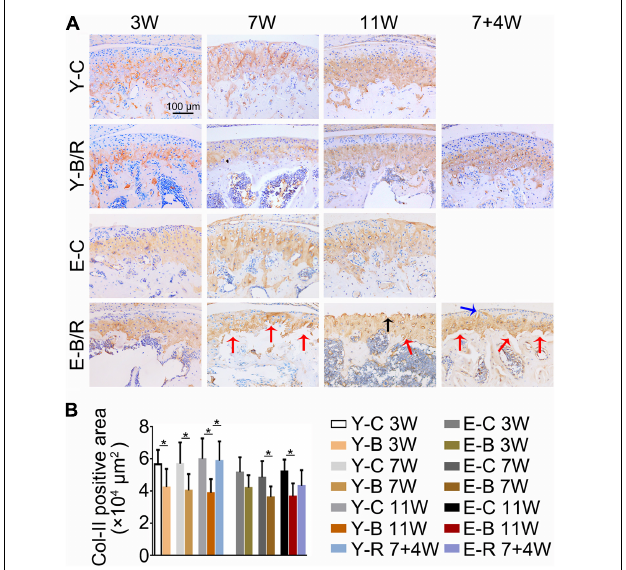
FIGURE 8 | (A) Representative immunohistochemical staining of type II collagen (Col-II). The black arrow indicates the serrated injury at the surface of the cartilage. The blue arrow indicates the fissure at the surface of cartilage. The red arrows indicate the fissures between the cartilage and subchondral bone. Bars = 100 µ m. (B) Comparisons of Col-II positive area between the groups. Data are presented as mean ± SD. Unpaired t -test was used for comparisons between the age-matched control and BAC groups. One-way ANOVA was used for comparisons among the age-matched control, BAC, and BAC removal groups. n = 6. * P < 0.05 for the differences between all BAC and removal groups and the age-matched control groups. For grouping and time points, please refer to Figure 1A .